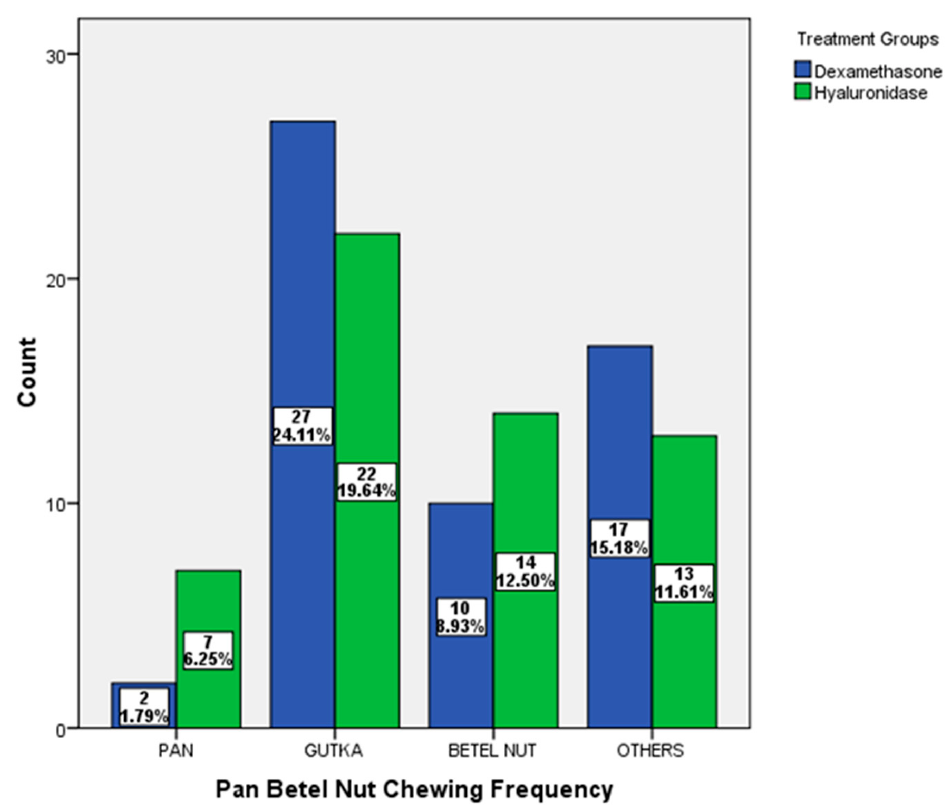
Figure 1. Distribution of chewing habits according to the treatment groups.